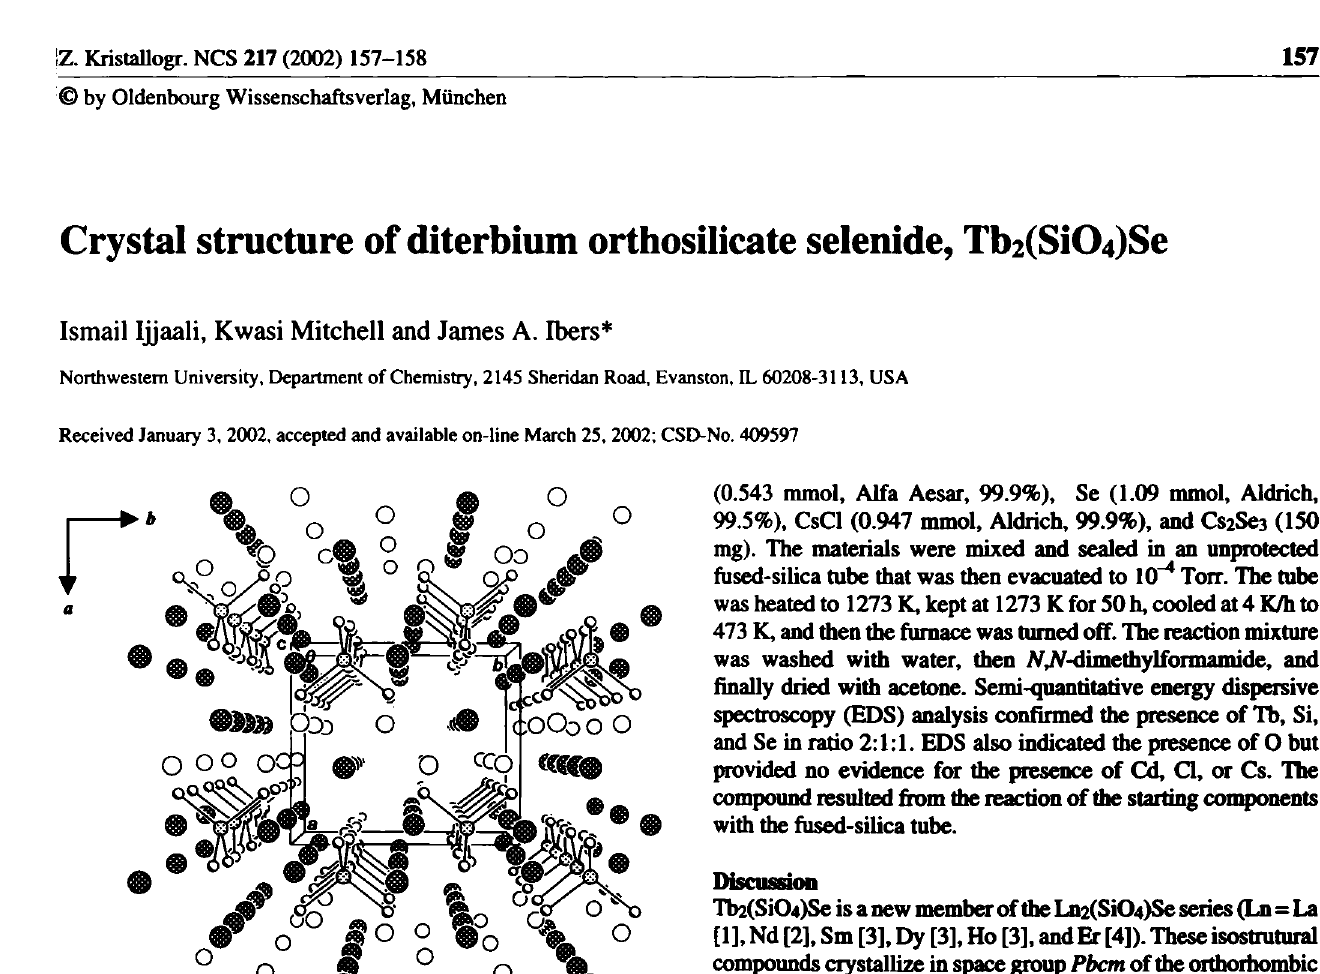
Table 1. Data collection and